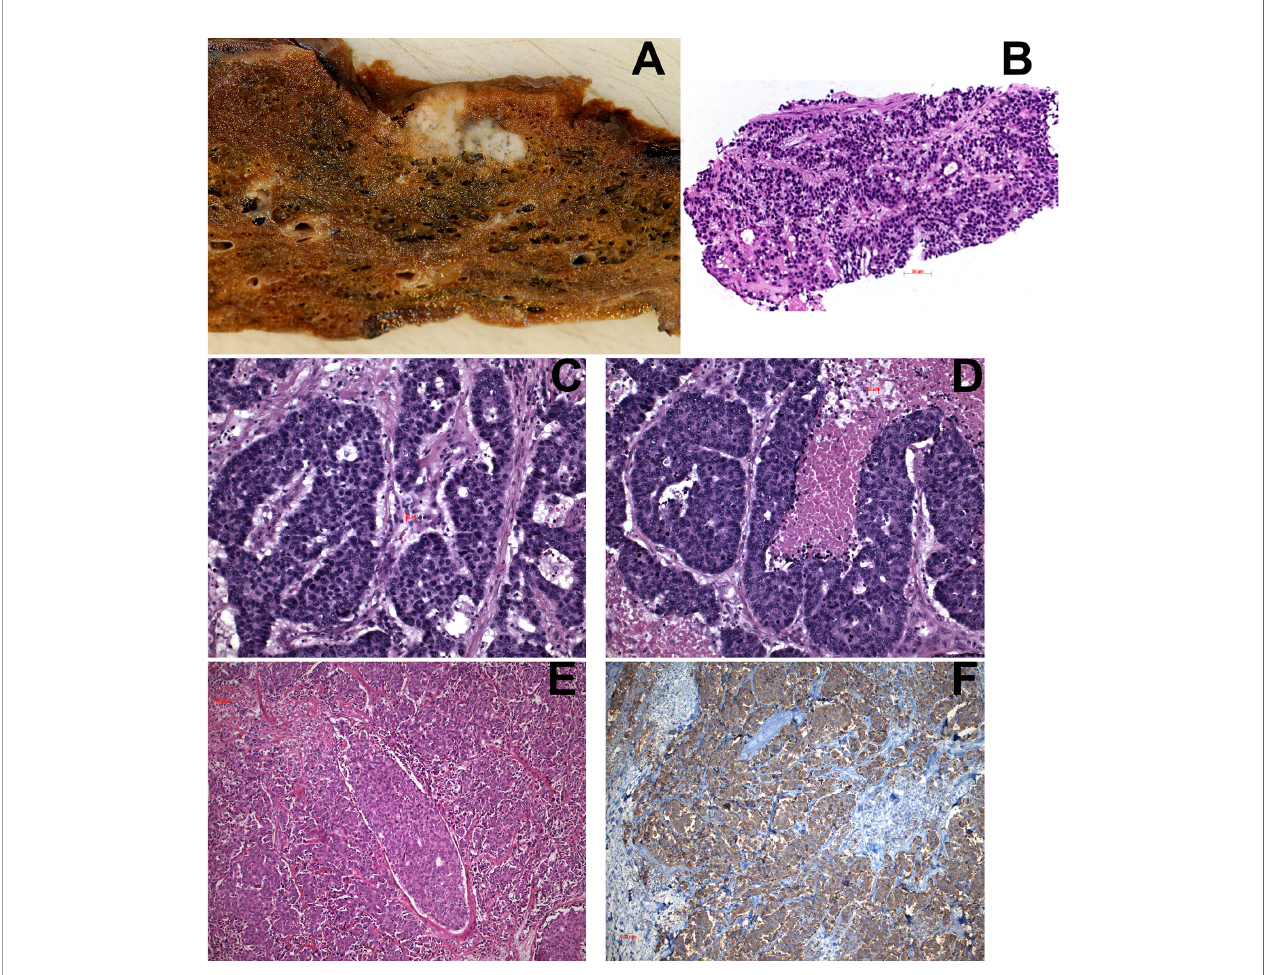
FIGURE 1 | (A) Macroscopy of LCNEC, showing two nodular lesions separated by a small bridge of parenchyma; areas of necrosis are seen on the left side. (B) transthoracic needle biopsy of a LCNEC. (C, D) Examples of LCNEC with neuroendocrine morphology (rosettes) and areas of necrosis in (D) . (E) Another LCNEC without neuroendocrine morphology. (F) Immunohistochemistry in this case showed positivity for CGA in almost 100% of tumor cells. H&E and IHC for CGA, magni fi cations x70, x200, and